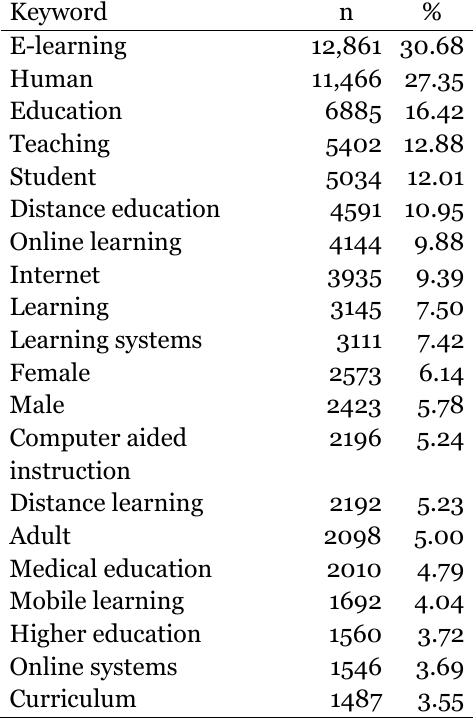
Table 2 Top 20 Keywords Addressed by E-Learning Articles